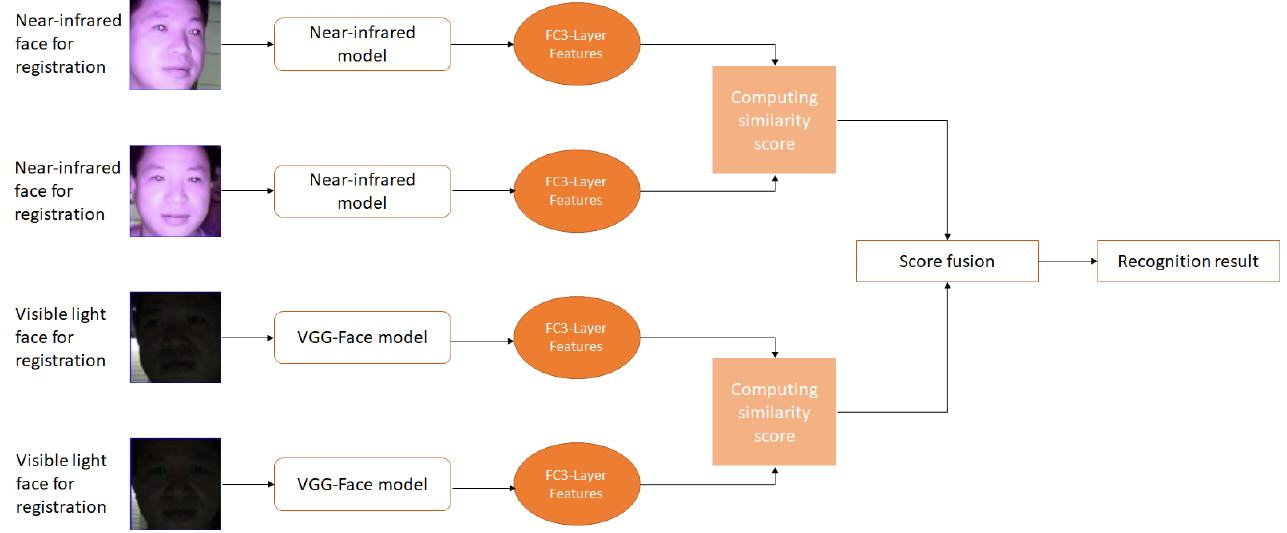
Figure 11. Score fusion process